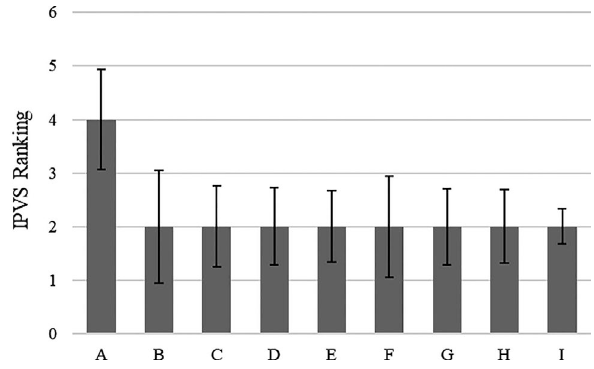
Figure 2 - IPVS Ranking and its respective standard deviations regarding the surroundings of each public swimming pool in the municipality of Limeira, SP. Source: own elaboration.